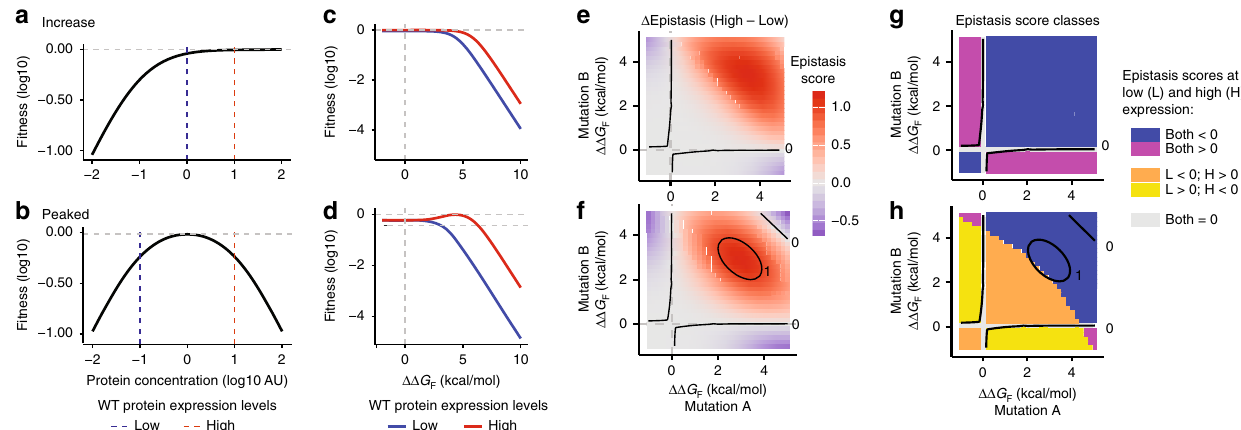
Fig. 5 Expression- fi tness functions generate concentration-dependent genetic interactions. a , b Two common expression- fi tness functions in budding yeast. c , d Relationship between change in free energy of protein folding and fi tness for these functions. e , f change in epistasis magnitude between high and low expression. g , h Change in epistasis sign between high and low expression